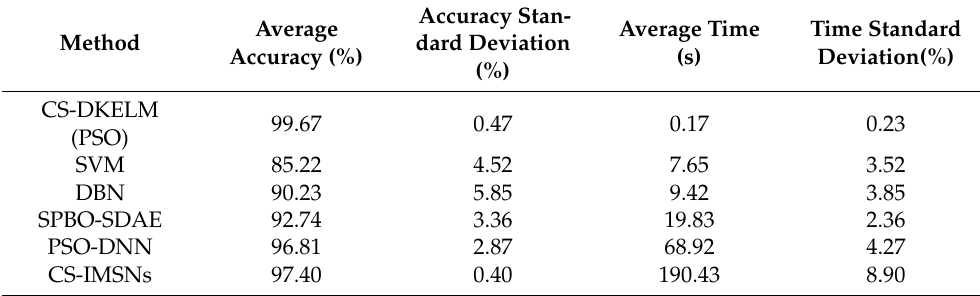
Table 8. Performance of CS-DKELM on the actual hardware